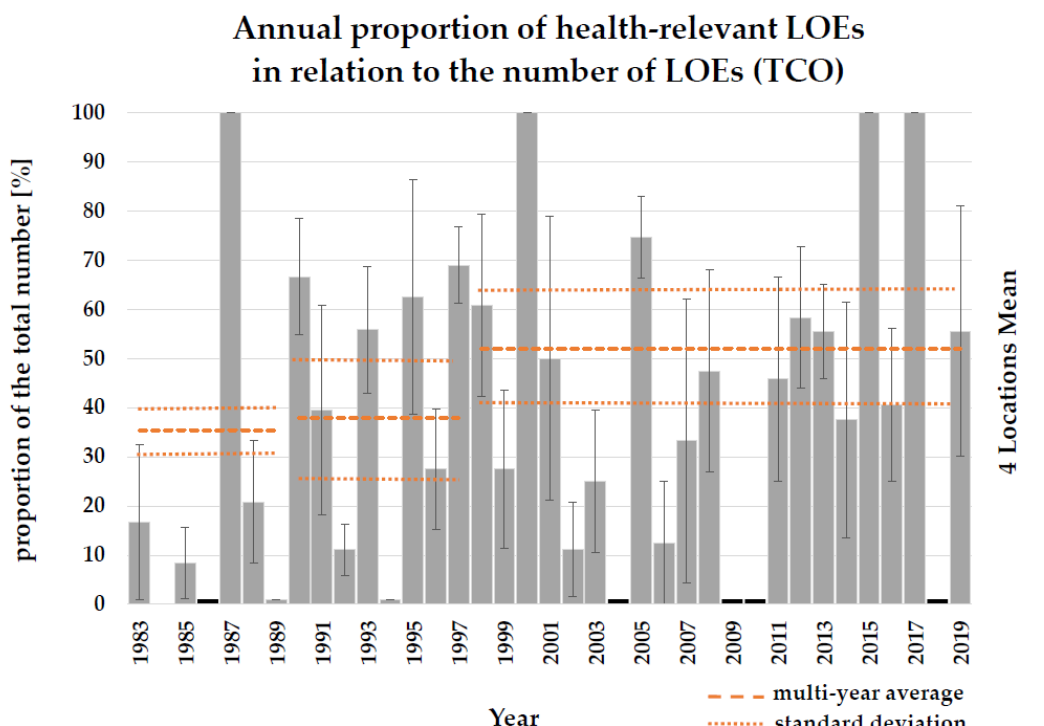
Figure 5. Mean annual proportion of days on which LOEs and anomalies of erythema-effective UV irradiation occur at the same time in relation to the number of days with LOEs due to anomalies of TCO, together with the averages and standard deviations of the subperiods T1 (1983–1989), T2 (1990–1997), T3 (1998–2019) (orange dashed lines) (grey: 4-location means and standard deviation).